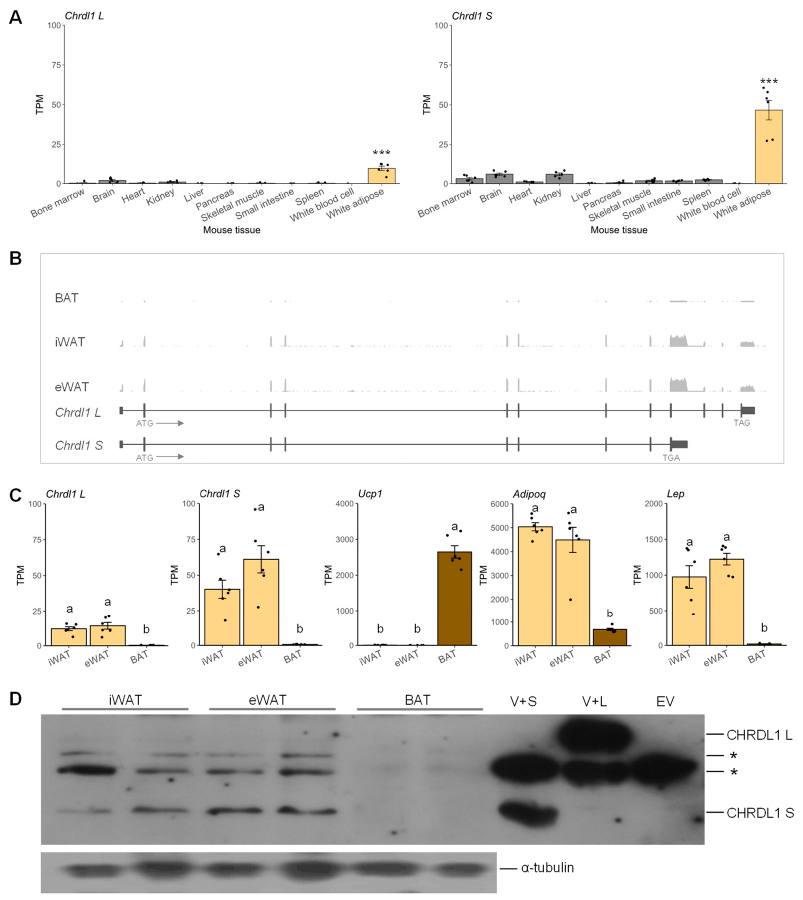
Figure 1. Analysis of Chrdl1 mRNA and CHRDL1 protein expression levels in mouse tissues. ( A ) The Chrdl1 L (long-form) and Chrdl1 S (short-form) mRNA expression levels in various mouse tissues. Normalized expression levels in transcripts per million (TPM) values are presented as mean ± SEM. ***, p < 0.001. ( B ) Schematic representation of exon and intron structure of the mouse Chrdl1 gene and the averages of RNA-seq read coverages in BAT, inguinal (iWAT), and epididymal WAT (eWAT) presented in Figure S3B. Arrows denote transcriptional direction. ( C ) The mRNA expression levels of Chrdl1 L , Chrdl1 S , brown-fat-selective gene ( Ucp1 ), and white adipose tissue markers ( Adipoq and Lep ) in iWAT, eWAT, and BAT. TPM values are presented as mean ± SEM. Different letters, a and b, denote statistical difference at a significance level of α = 0.05. ( D ) Western blot analysis of CHRDL1 protein expression in mouse white and brown adipose tissues. The experiment was conducted in duplicate. V+S, recombinant vector carrying CHRDL1 short-form protein (CHRDL1 S); V+L, recombinant vector carrying CHRDL1 long-form protein (CHRDL1 L); EV, empty-vector control; *, non-specific band. The α -tubulin protein was used as a loading control.